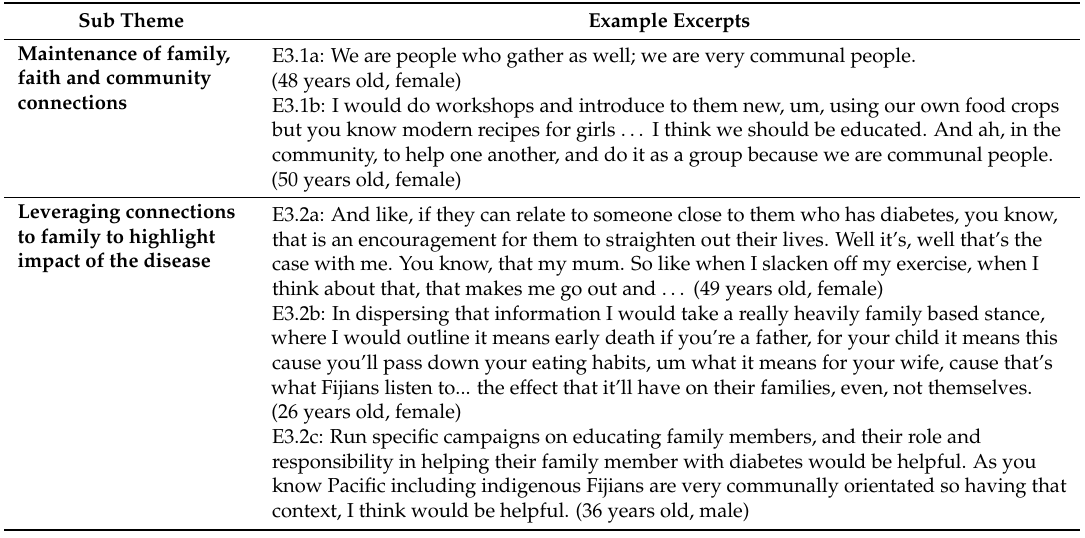
Table 4. Excerpts related to facilitators for preventing diabetes and its